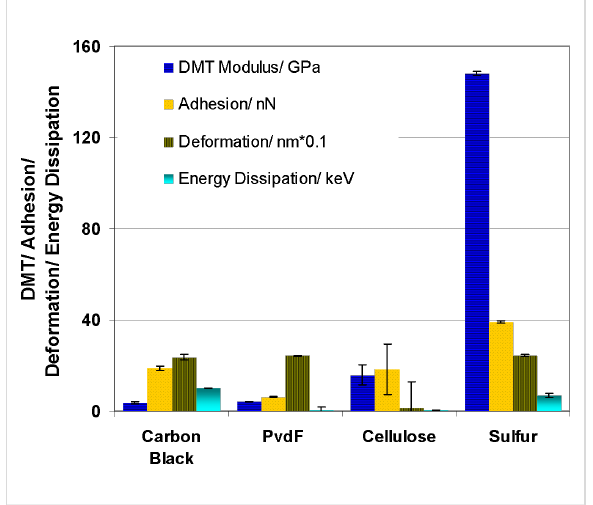
Figure 5: Statistical evaluation of mechanical properties of the basic materials used for preparing the cathodes.